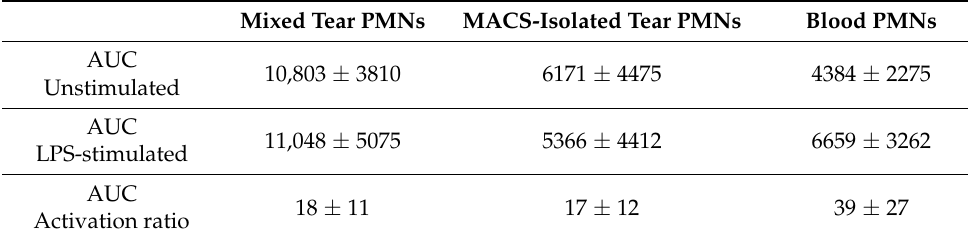
Table 1. Absolute and relative ROS production in unstimulated and LPS-stimulated PMNs, as measured by AUC. Mixed Tear PMNs MACS-Isolated Tear PMNs Blood PMNs AUC Unstimulated AUC LPS-stimulated AUC Activation ratio AUC (area under the curve) was computed using GraphPad Prism software. n = 12 from 10 participants for mixed tear PMNs, n = 6 from 6 participants for MACS-isolated tear PMNs, and n = 5 from 4 participants for blood PMNs; values are represented as means ± standard deviations.